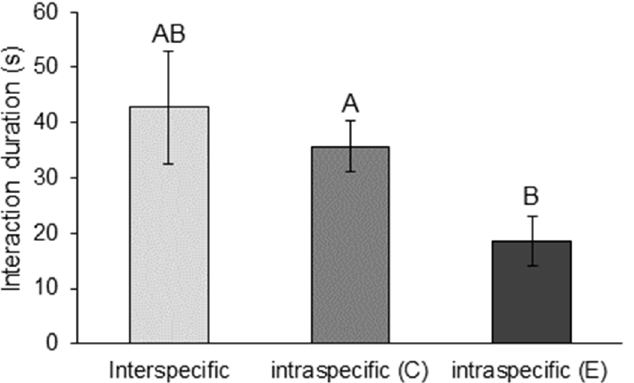
Figure 1. Mean time (s) ( ± SE) crayfish spent interacting in interspecific interactions and intraspecific interactions between Cherax destructor (C) and Euastacus dharawalus (E). Different letters denote significant differences based on Tukey’s post hoc tests.